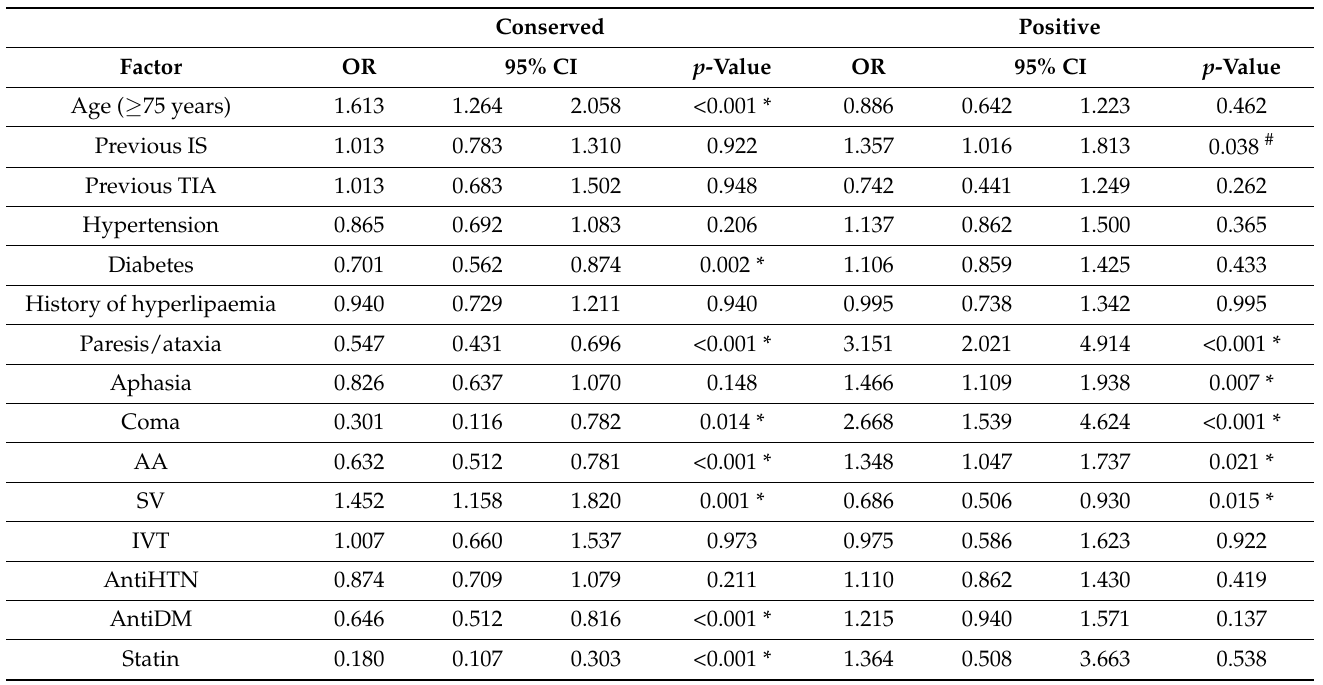
Table 6. Univariate analysis of the determinants associated with the antiplatelet regimen choice in noncardiac stroke